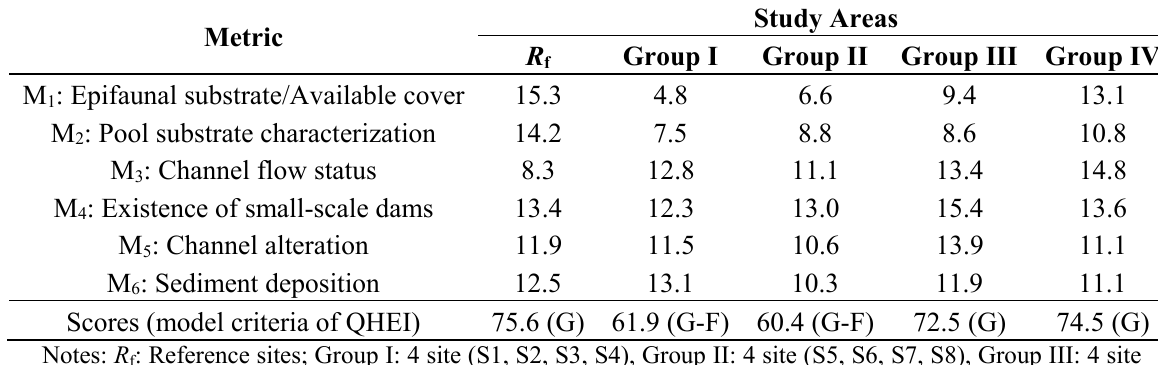
Table 3. Physical habitat health assessment, based on the Qualitative Habitat Evaluation Index (QHEI), in the watershed of Nakdong